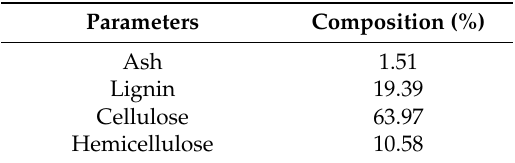
Table 3. Composition of OPEFB after NaOH pretreatment.